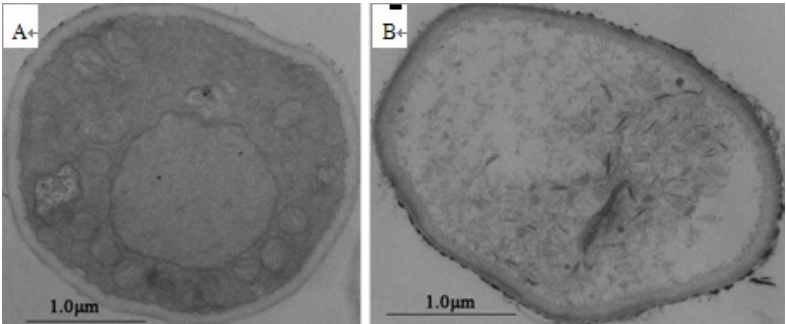
Figure 6. Transmission electron microscopy of mycelial ultrastructure of B. maydis treated by total saponin at a concentration of 250 μ g/mL for 24 h. ( A ) Healthy mycelium; ( B ) treated mycelium; A ×7,000 and B ×10,000